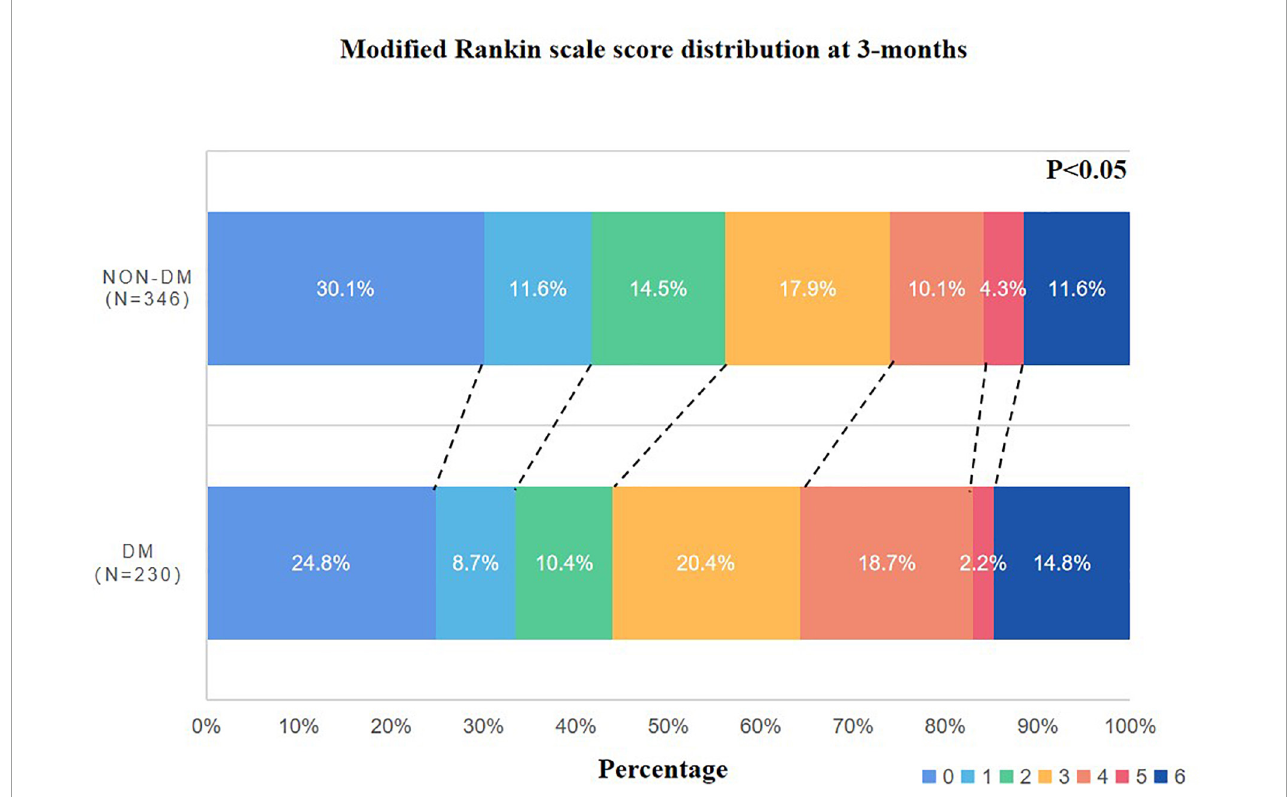
FIGURE2 Distribution of mRS scores at 3 months between patients with and without